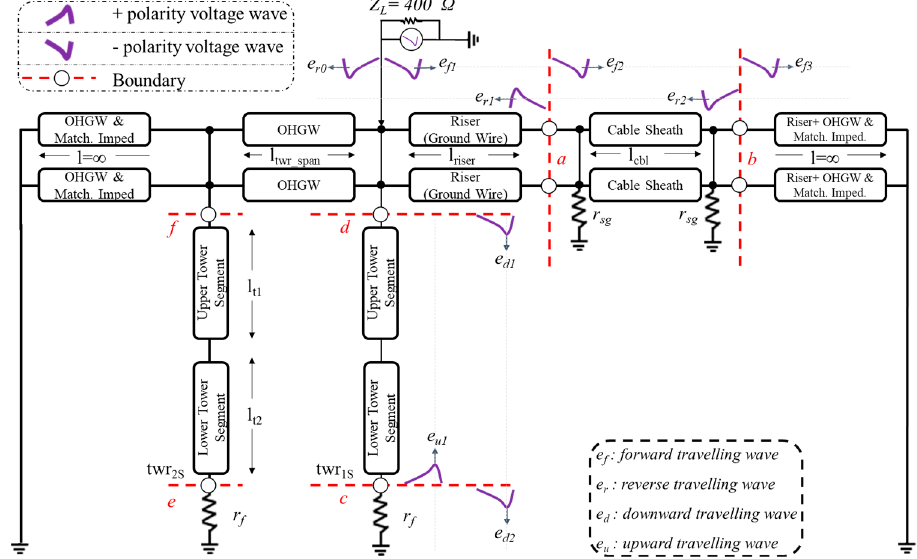
Figure 15. An equivalent circuit of a mixed HVDC transmission line for analysis of a lightning strike on the OHGW/tower top (only the two towers closest to the sending end of the cable are shown) (description of symbols is provided in Table 1).